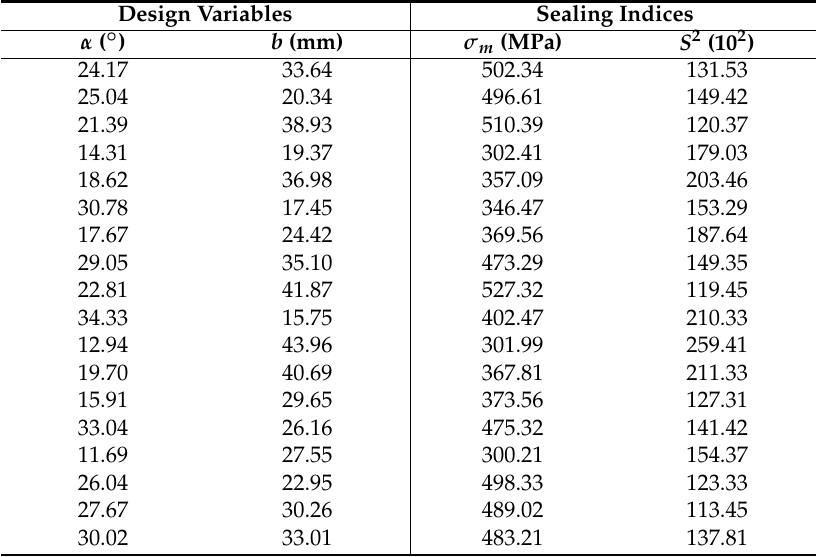
Table 3. The training samples of the sealing performance Kriging model.